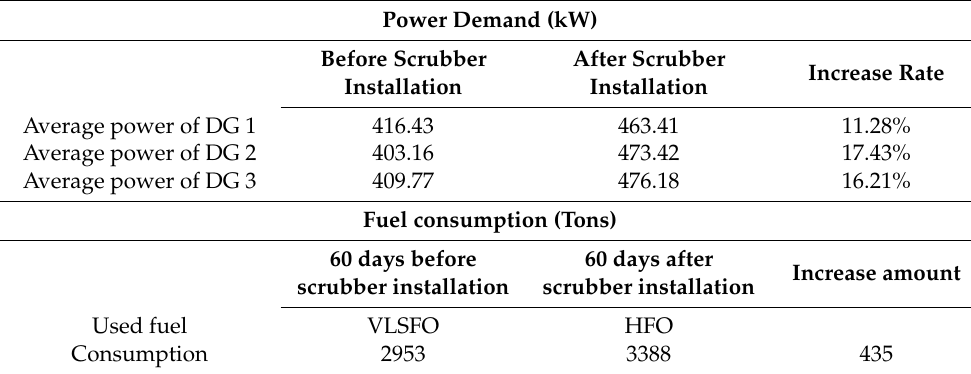
Table 5. Results of power and fuel analysis.